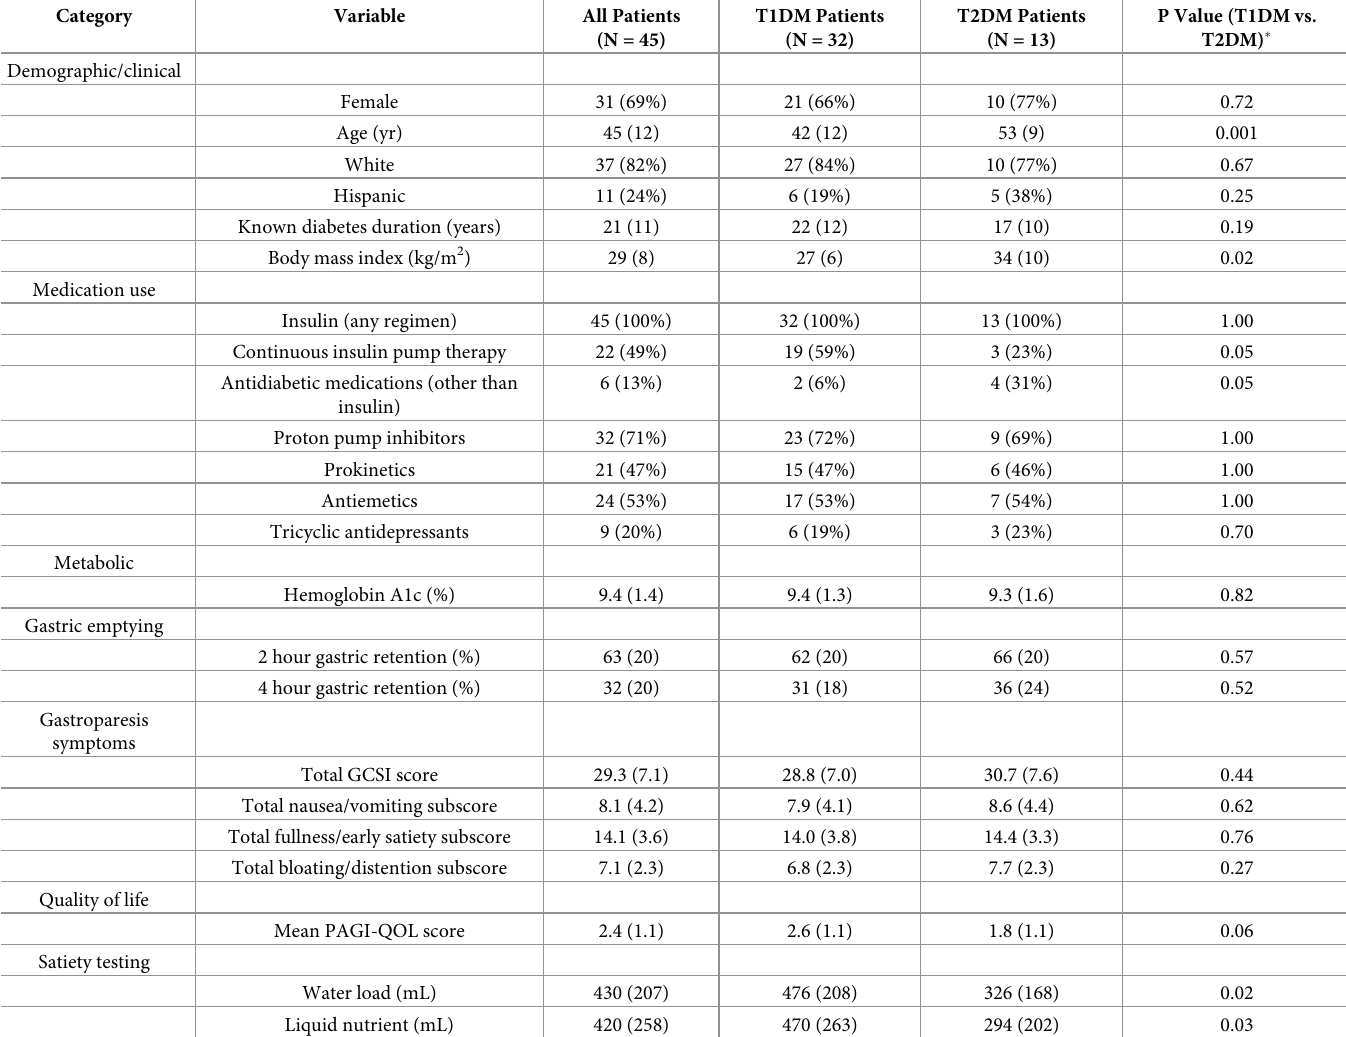
Table 1. Patient characteristics at